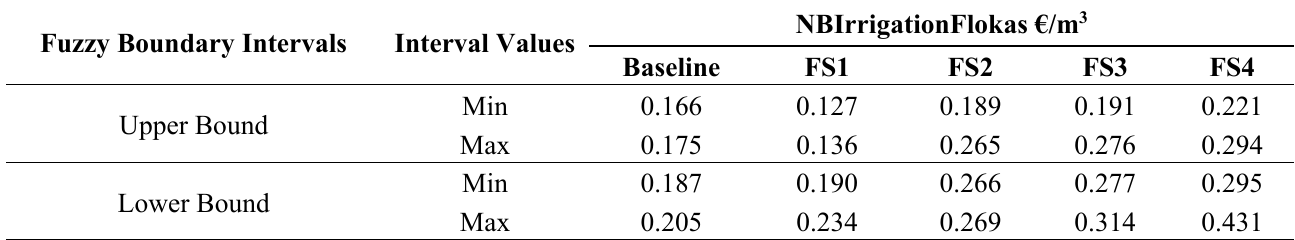
Table 7. Unit benefit from irrigation for the baseline and the future scenarios for the Flokas irrigation scheme, € /m 3 . FS, future